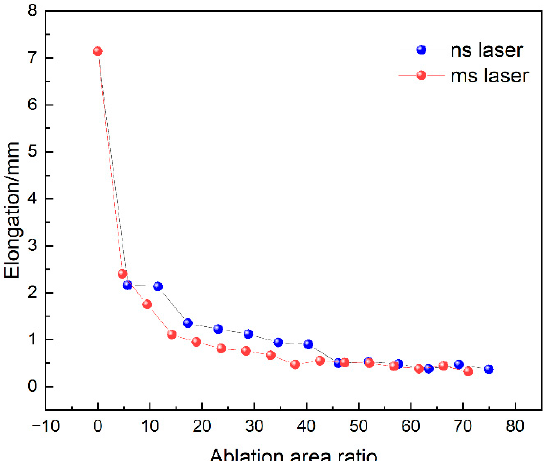
Figure 3. Elongation of nanosecond and millisecond laser ablated aluminum alloys as a function of ablation area ratio.